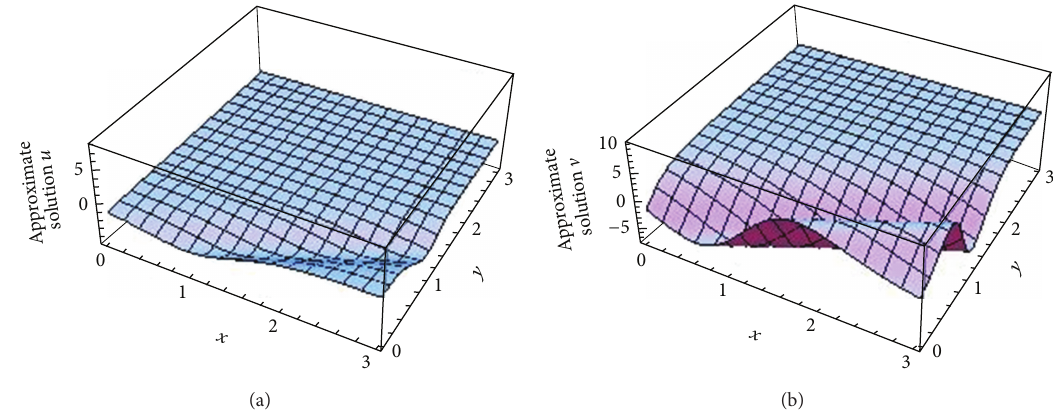
Figure 4: The surfaces show (a) the numerical approximate solution of 𝑢(𝑥,𝑦, 0.1) and (b) the numerical approximate solution of V (𝑥,𝑦, 0.1) when 𝛼 = 0.88 and 𝛽 = 0.005